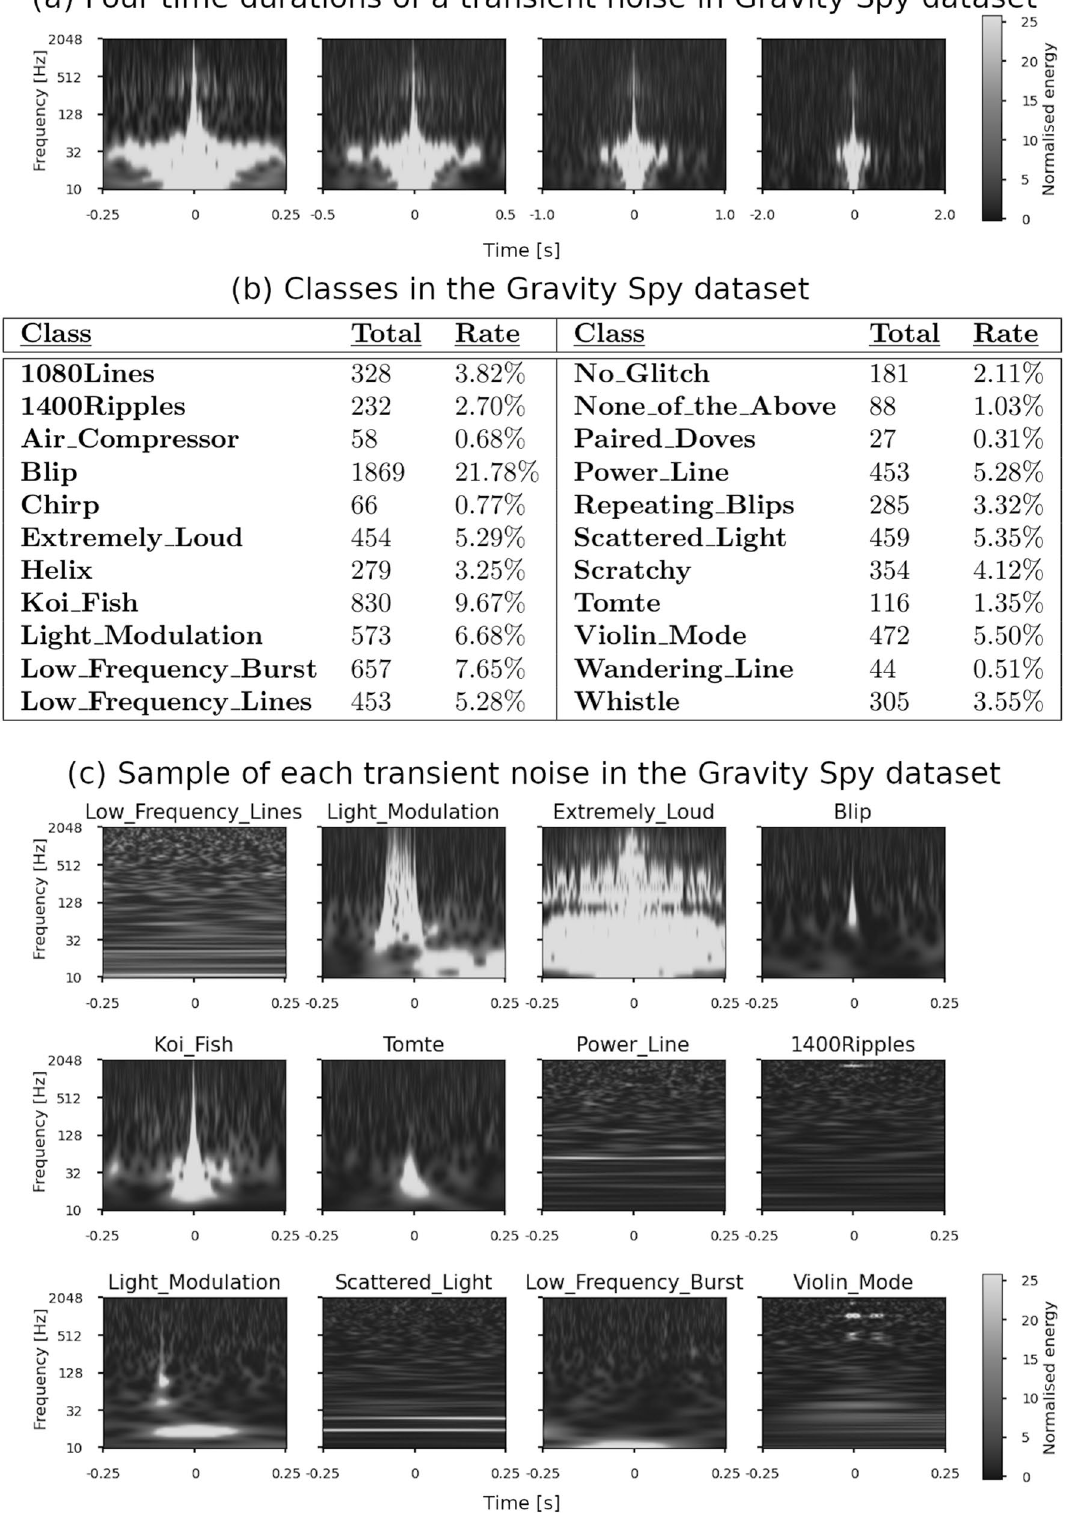
Figure 1. ( a ) Example of 2D image of the time–frequency spectrogram of transient noise in the Gravity Spy dataset. Regarding each transient noise, four time durations (0.5, 1.0, 2.0, and 4.0 s from the left of the figure) are recorded from the centre time. ( b ) Table showing all the classes, the number of data, and its ratio to the number in the Gravity Spy dataset. There are 22 classes in total, and each of 21 classes is given a name related to an occurrence cause or a characteristic of the shape on the spectrogram of transient noise. The other is “None_ of_the_Above”, which does not belong to any class. ( c ) Example of the image for each class in the Gravity Spy dataset. The figure shows 12 of the 22 classes of the transient noise with 0.5